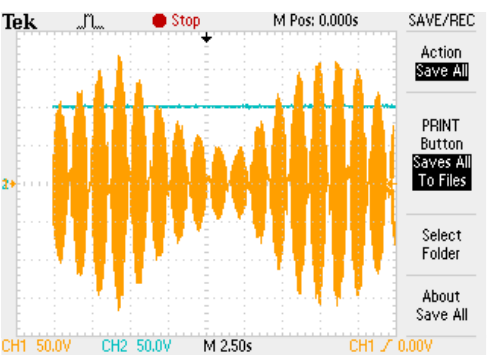
Figure 16. Experimental results of DC link voltage and the emulated electrical outputs for LWEC driven with different wave amplitudes.